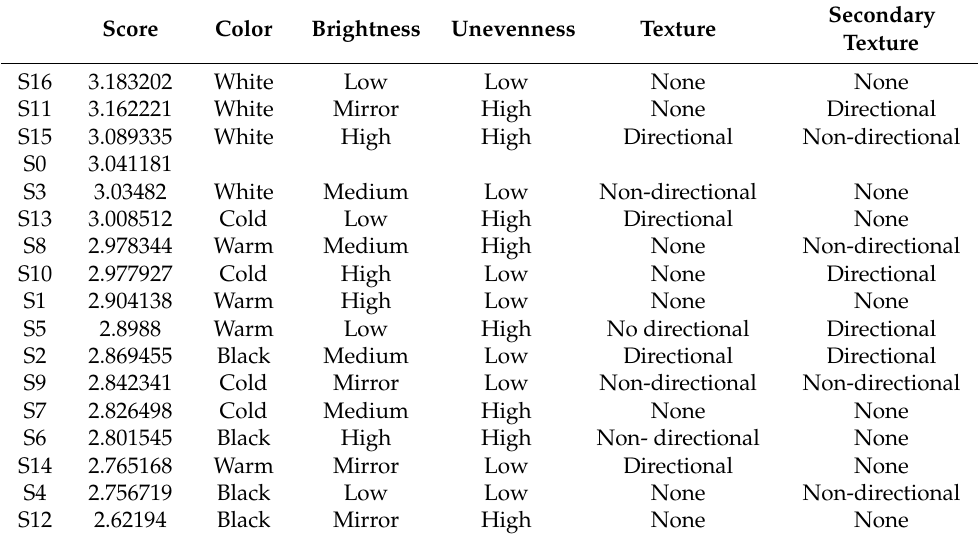
Table 10. Physical independent variables of each scene.